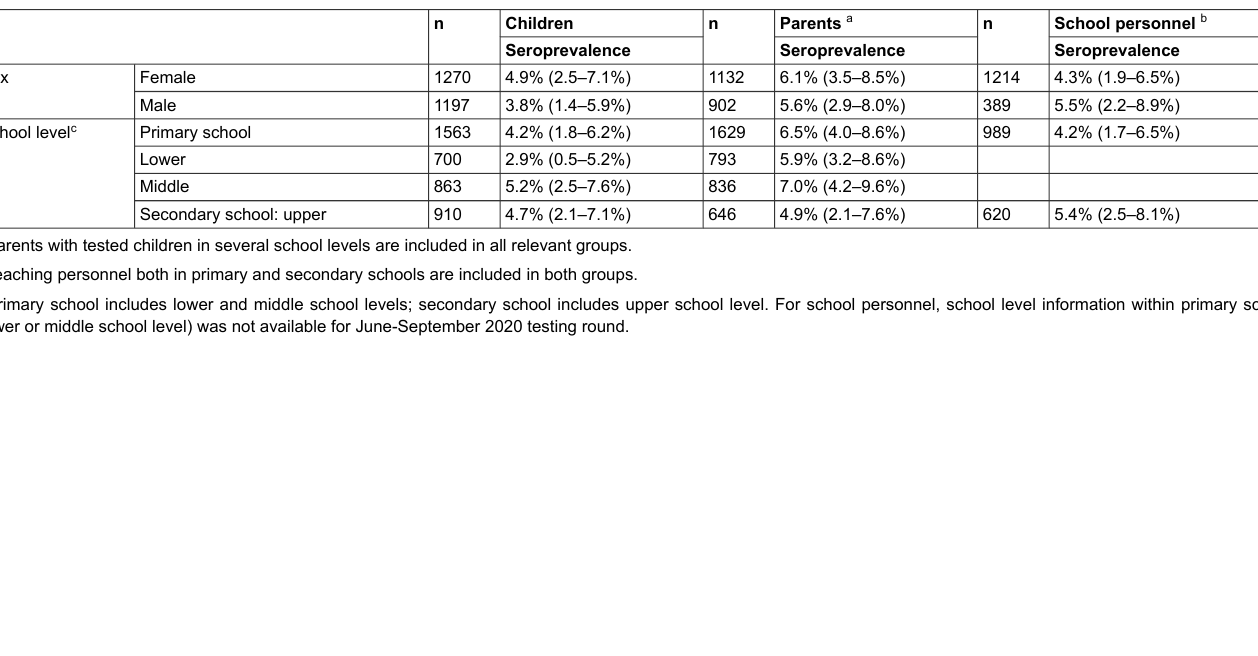
Table S4: Seroprevalence with 95% confidence interval in children, parents and school personnel based on sex and school level in June-September